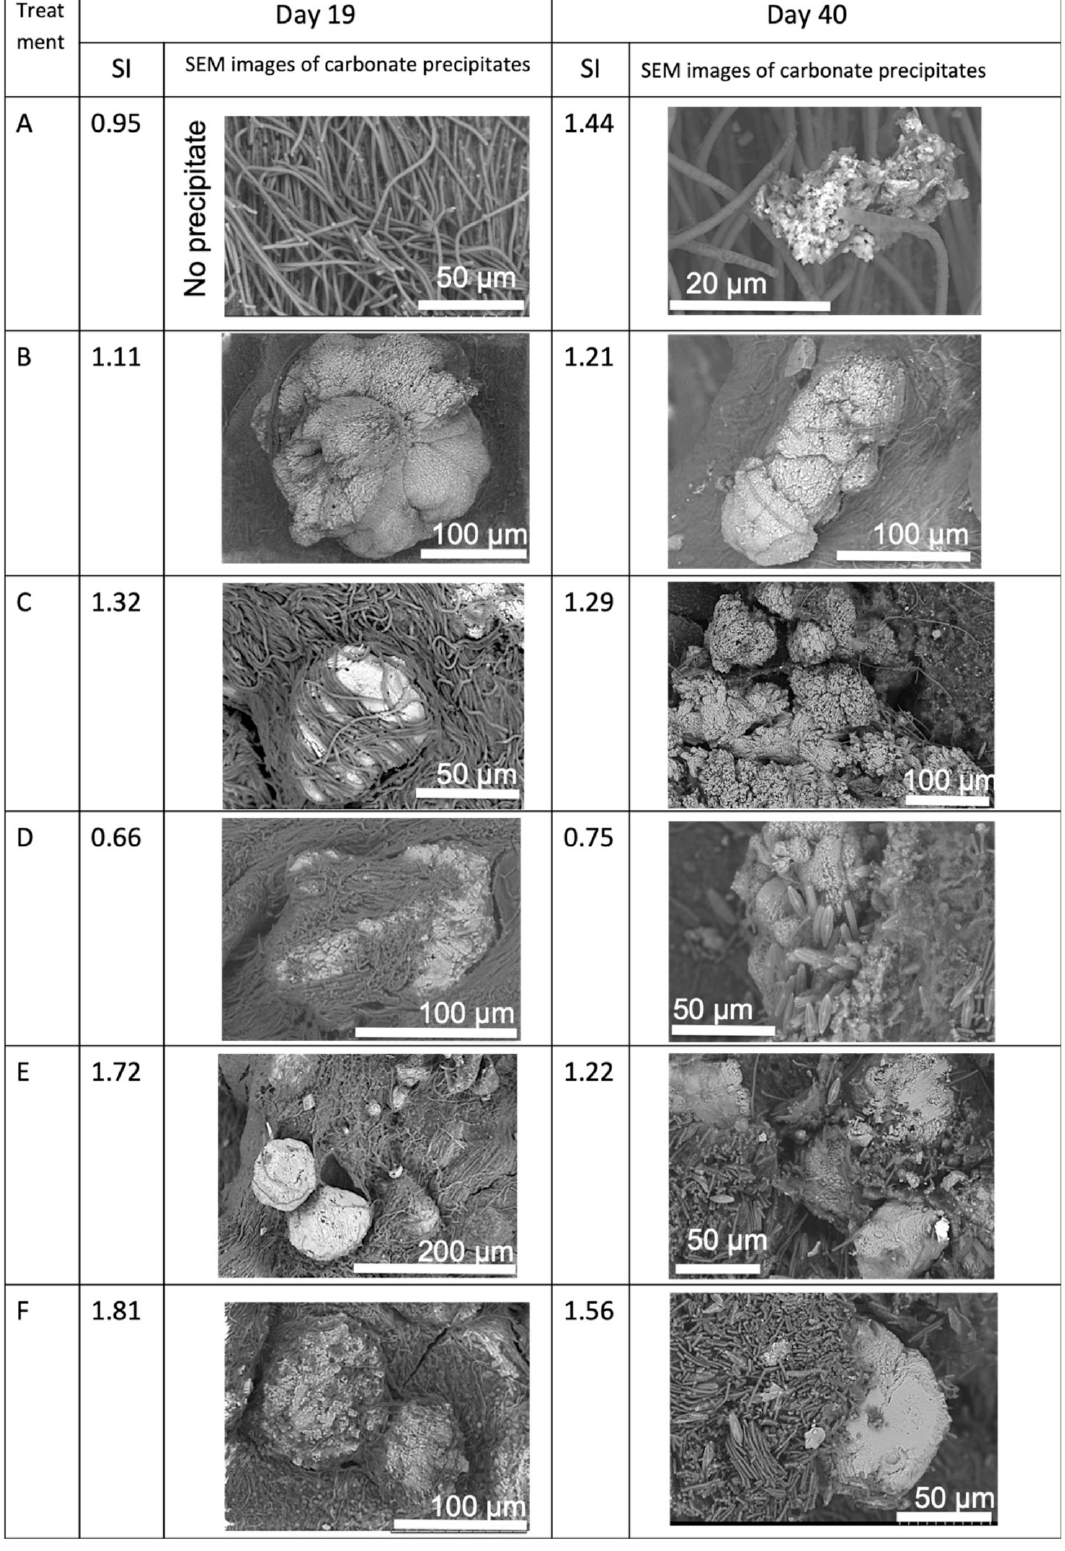
Figure 4. SEM images of carbonate precipitates in the experimental biofilm of Treatments ( A – F ) at Day 19 and Day 40. SI indicates the saturation index of calcite for each